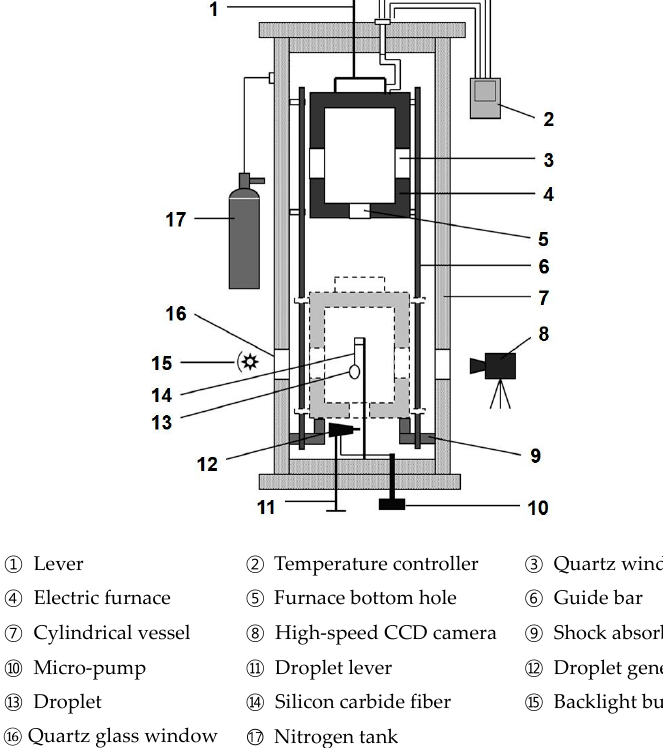
Figure 1. Schematic drawing of experimentation.